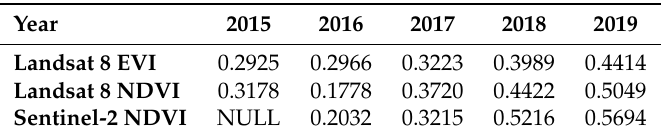
Table 5. Pearson’s linear correlation coefficient for the linear regressions. Sentinel 2 observed the Chongming island only once during the period of 21 June to 20 August 2015 (see Table 2) and the corresponding image contained most of the clouds, therefore the correlation coefficient cannot be